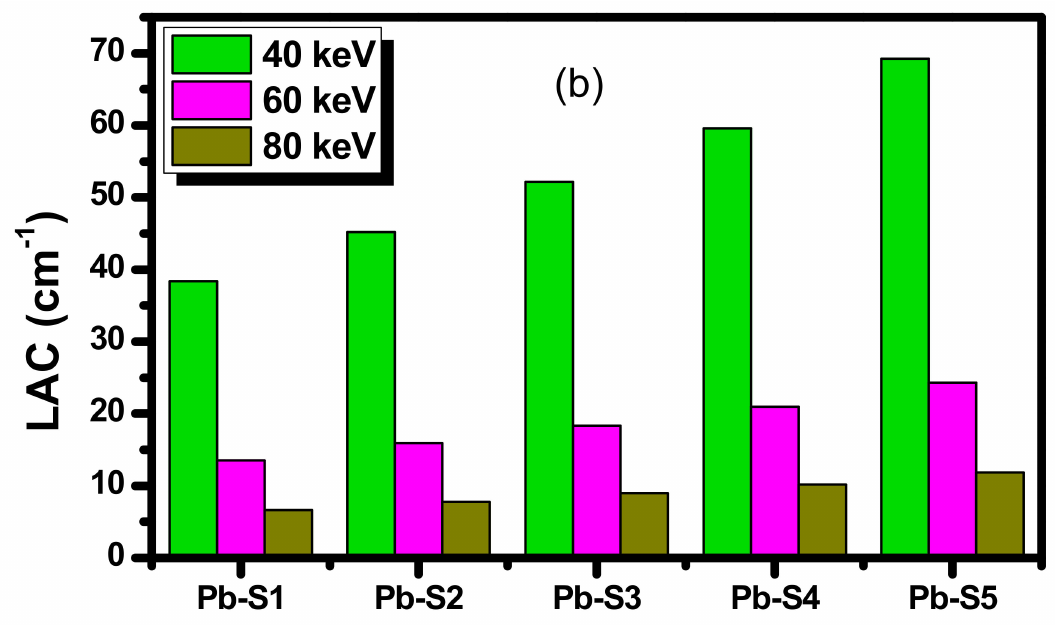
Figure 5. The LAC for the Pb-SX glasses at ( a ) four energies 20, 40, 60 and 80 keV and ( b ) at 40, 60 and 80 keV (In order to show the values at the three energies more clearly).